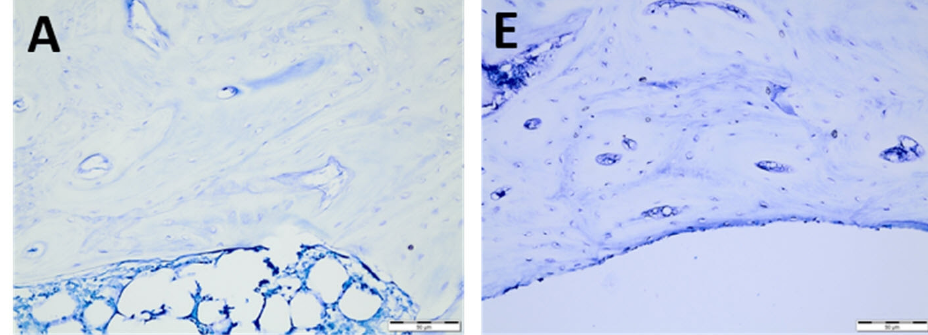
Figure 3. Histological sections of temperature-dependent bone tissue deterioration stained with to- luidine blue: − 40 °C cryoprobe area ( A – D ) for the control ( A ), 1 min ( B ), 2 min ( C ), and 5 min ( D ) and − 80 °C cryoprobe area ( E – H ) for the control €, 1 min ( F ), 2 min ( G ), and 5 min ( H ). Empty la- cunae (arrows) enlarged lacunae (arrowheads). Scale bar: 50 µm. High-resolution tif images of tib- ias that underwent − 40 and − 80 degrees cryotherapy are presented as Figure S1.tif and Figure S2.tif files, respectively. 2.6. Statistical Analyses The effect was evaluated by comparing the number of lacunae with osteocytes, empty lacunae, and lacunae greater than 5 µm and the number of osteons in a 10,000 µm 2 area. One-way analysis of variance (ANOVA) followed by Tukey’s multiple com- parison test was performed using GraphPad Prism version 9.3.1 for Windows,